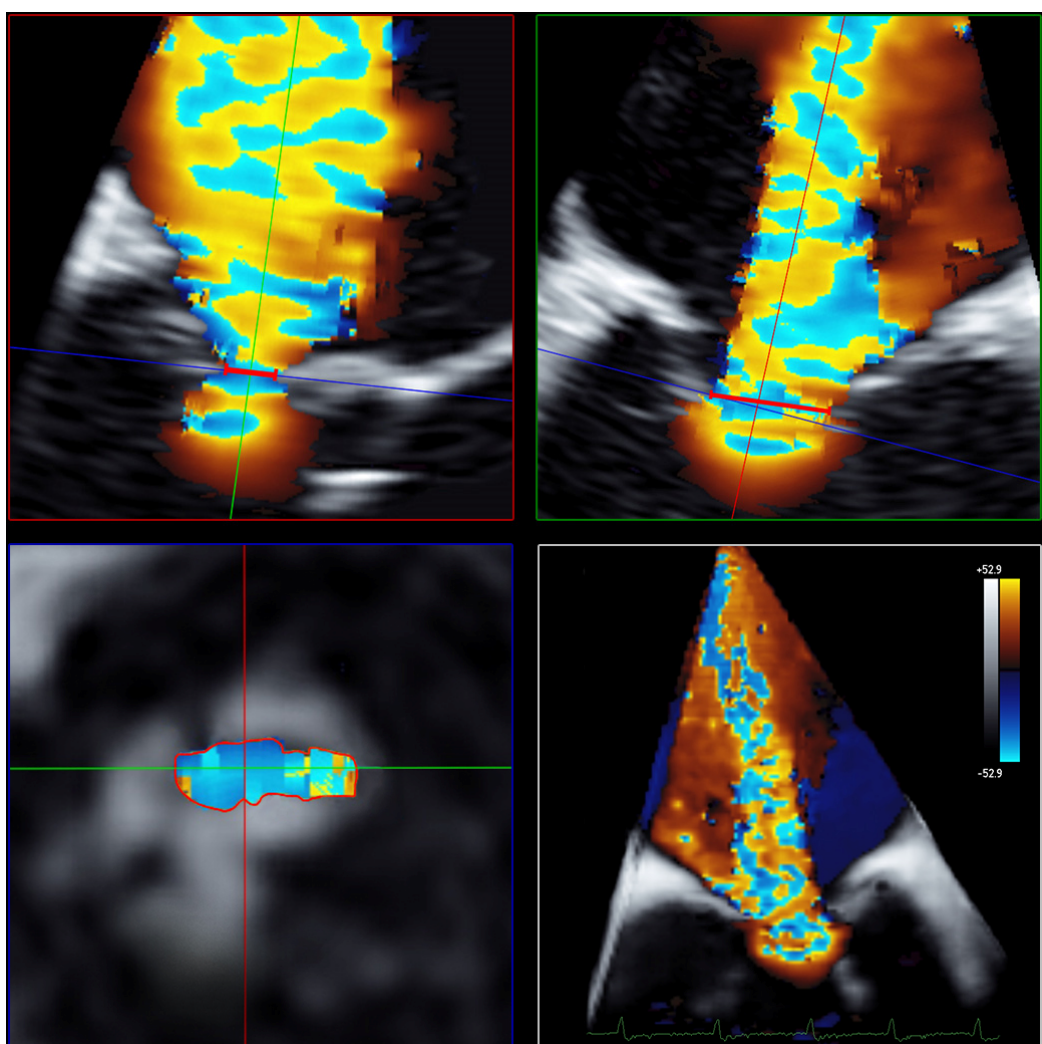
Figure 3. Determination of 3D VCA using multiplanar reconstruction in the 3D color Doppler dataset. Echocardiographic images with 3 slice planes and 3D reconstruction ( lower right ) of the 3D color Doppler dataset (mid-systolic). Planimetric fi tt ing of the 2 upper planes along the course of the color Doppler jet; third plane ( lower left ) adjustment orthogonal to planes along the jet and fi nding the minimal cross-section of the regurgitation jet using translation and tilting of the third plane; manual measurement of the minimal cross-sectional plane using outlining. Abbreviations: 3D = three-dimensional; VCA = vena contracta area.